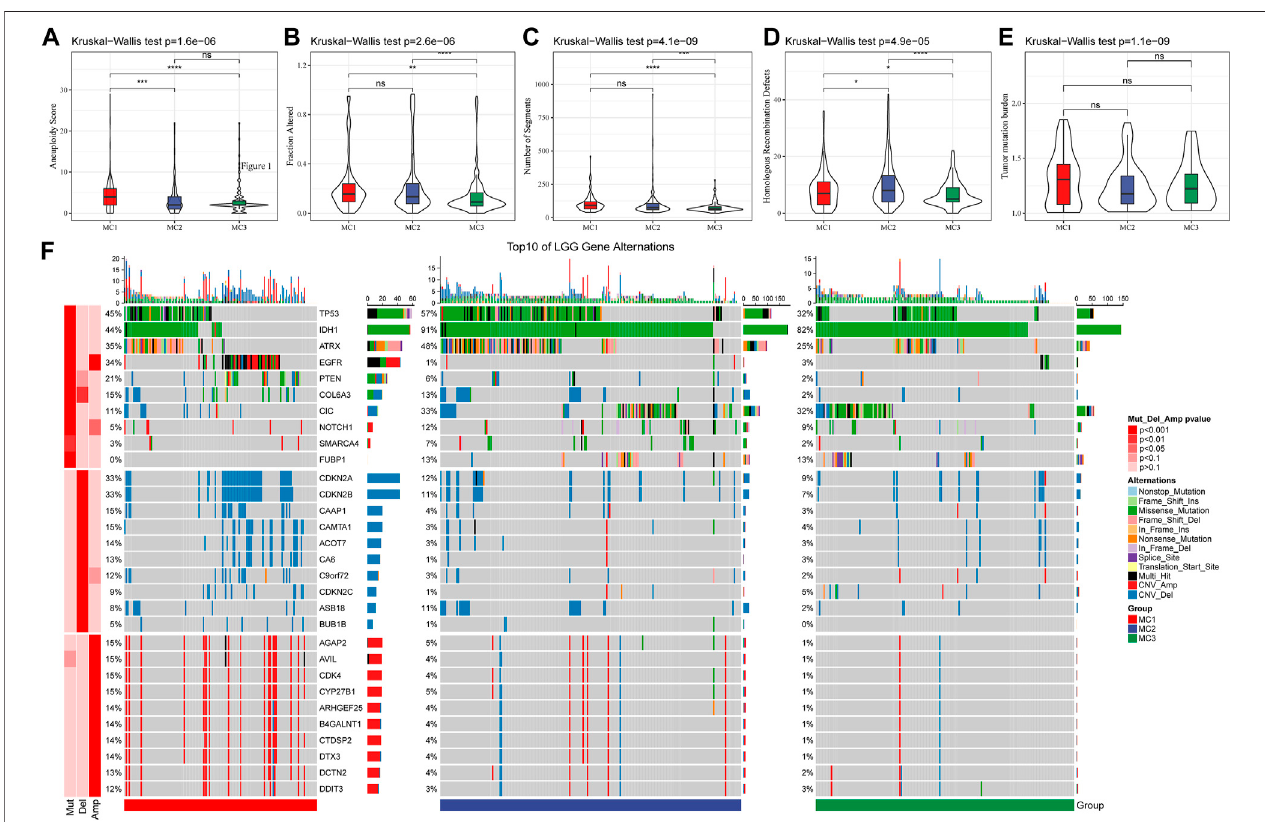
FIGURE2| Thegenomicalteration ofthe threeclustersintheTCGA cohort. (A – E) Comparisons ofaneuploidyscore, fraction altered, number ofsegments, tumor mutation burden and homologous recombination defects in the TCGA cohort. (F) The somatic mutations and copy number mutations of the three clusters.